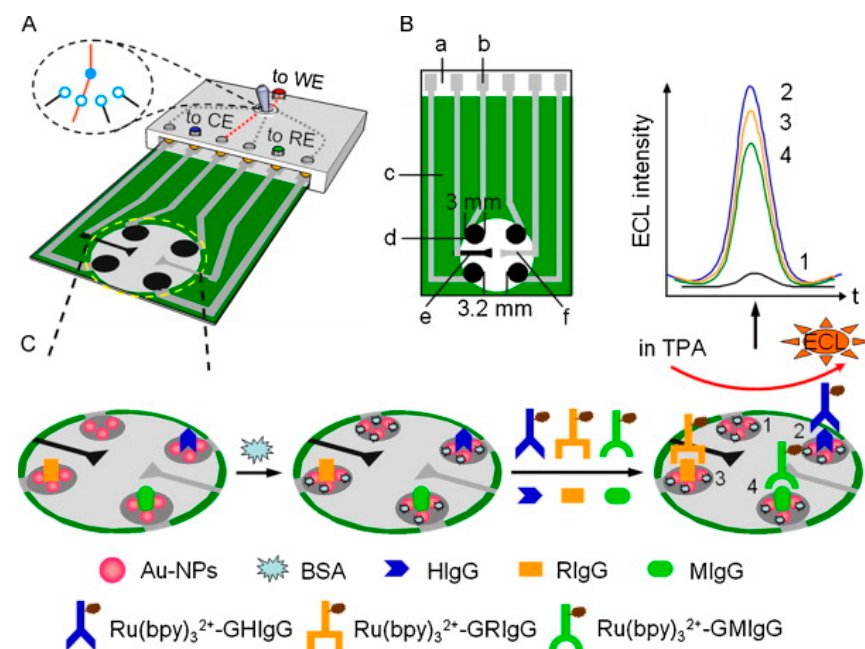
Figure 2. Schematic drawings of: ( A ) the immunosensor array for goat, rabbit and human immunoglobulins detection reported by Li et al. [67] , held and controlled by a single-pore-four-throw switch; ( B ) SPE array containing four working electrodes, one reference electrode and one counter; and ( C ) immunosensor array preparation and immunoassay procedure. ( a ) Polyethylene terephthalate; ( b ) Ag conductive channels; ( c ) insulating layer; ( d ) carbon working electrode (WE); ( e ) carbon counter electrode (CE); and ( f ) Ag / AgCl reference electrode (RE). Reproduced and adapted with permission of Elsevier.